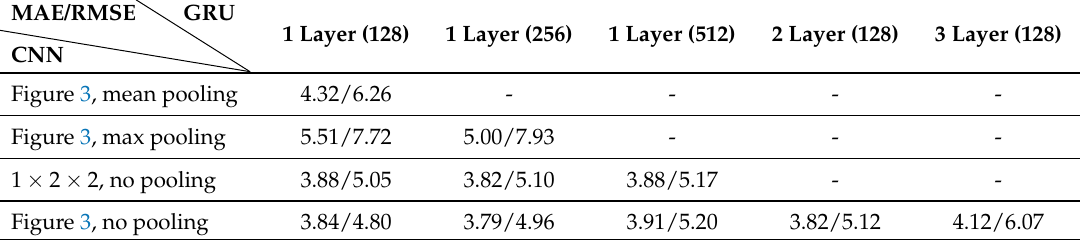
Table 2. Quantified performance of different model structures.